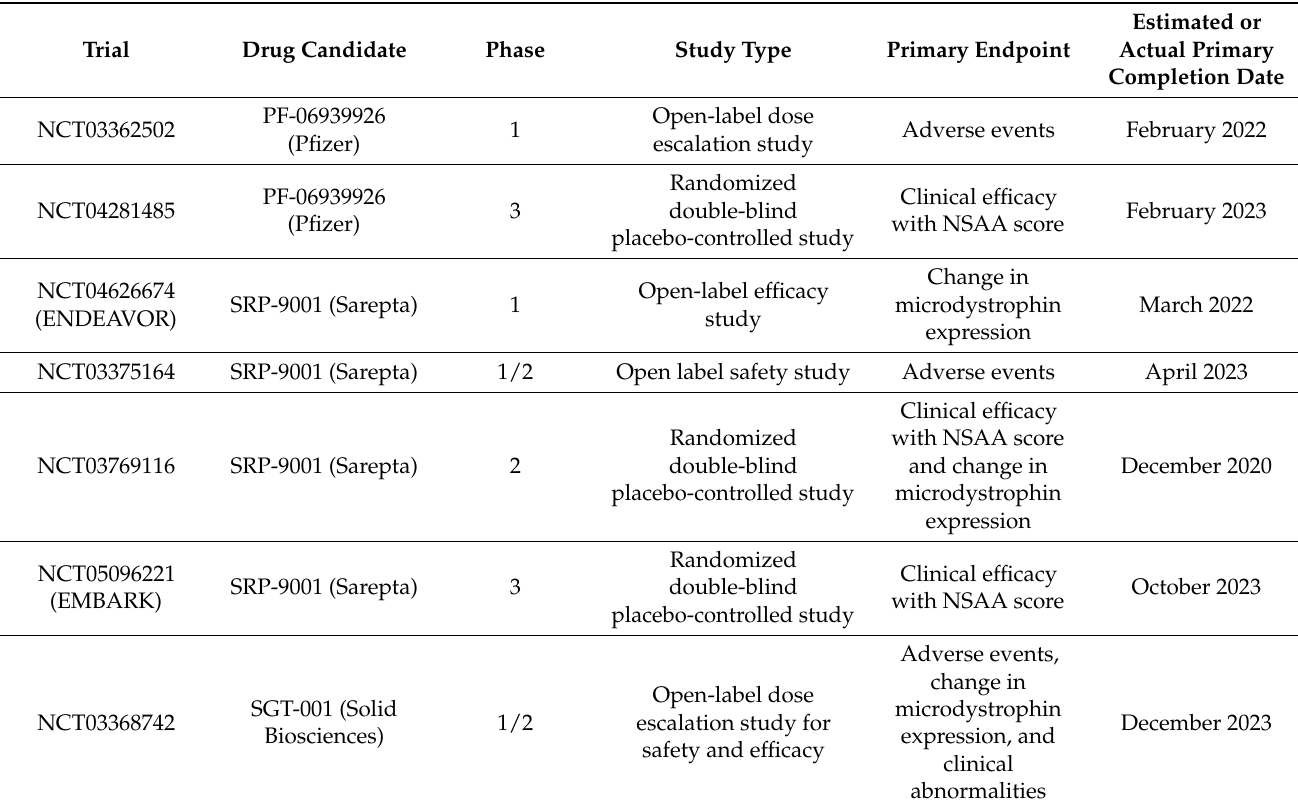
Table 1. A summary of clinical trials currently underway for microdystrophin therapy indicating phase, sponsoring agency, study type, endpoints, and end